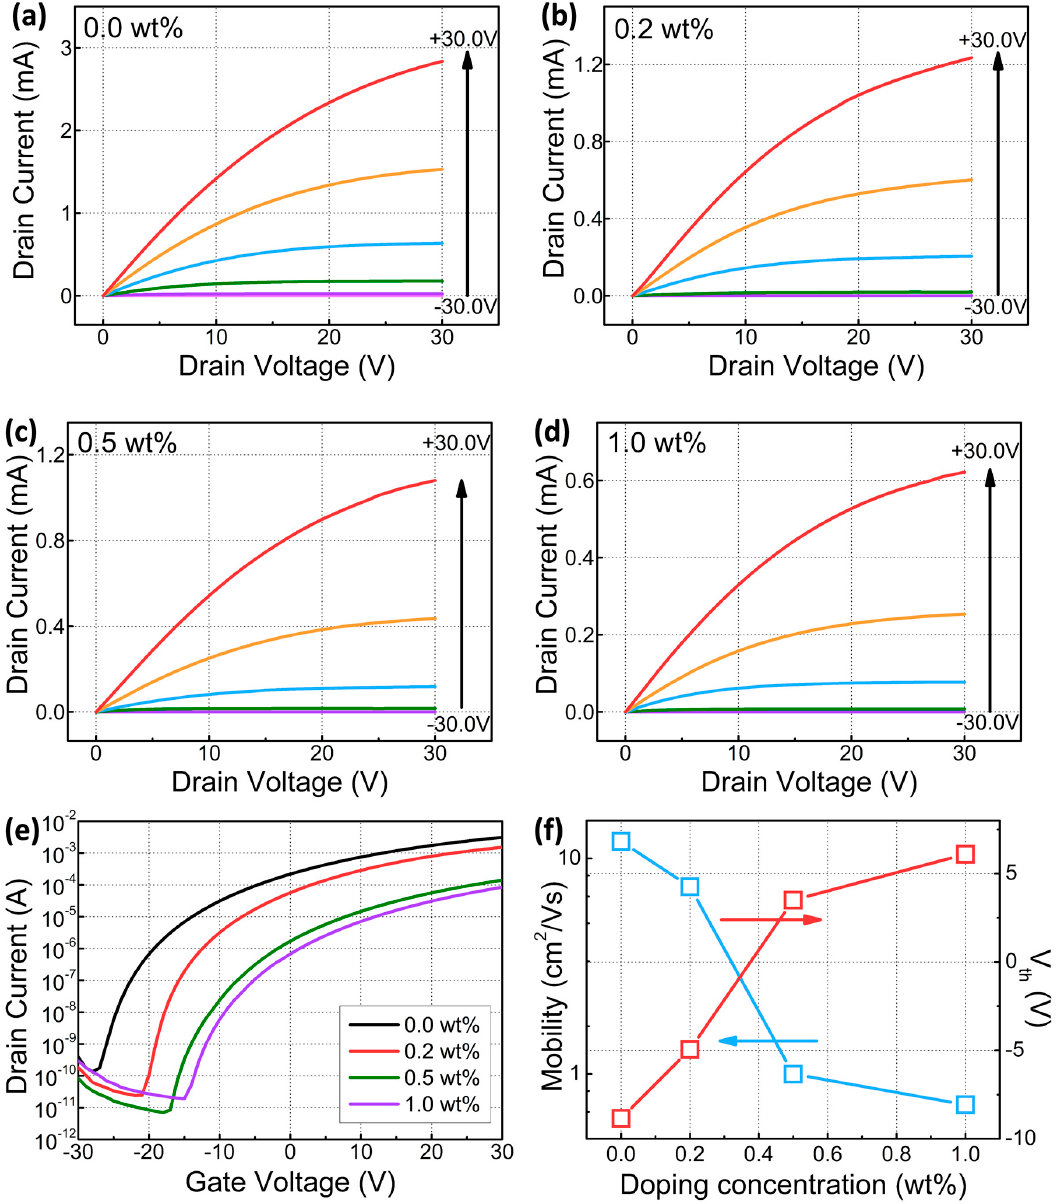
Figure 5. Representative electrical characteristics of the fabricated Y-doped SnO 2 thin film transistors: ( a – d ) I D -V D curves with 0.0, 0.2, 0.5, 1.0 wt% Y, respectively. ( e ) I D -V G curves at high V D ( + 30.0 V). ( f ) Y concentration dependence on the field e ff ect mobility in saturation regime and V th